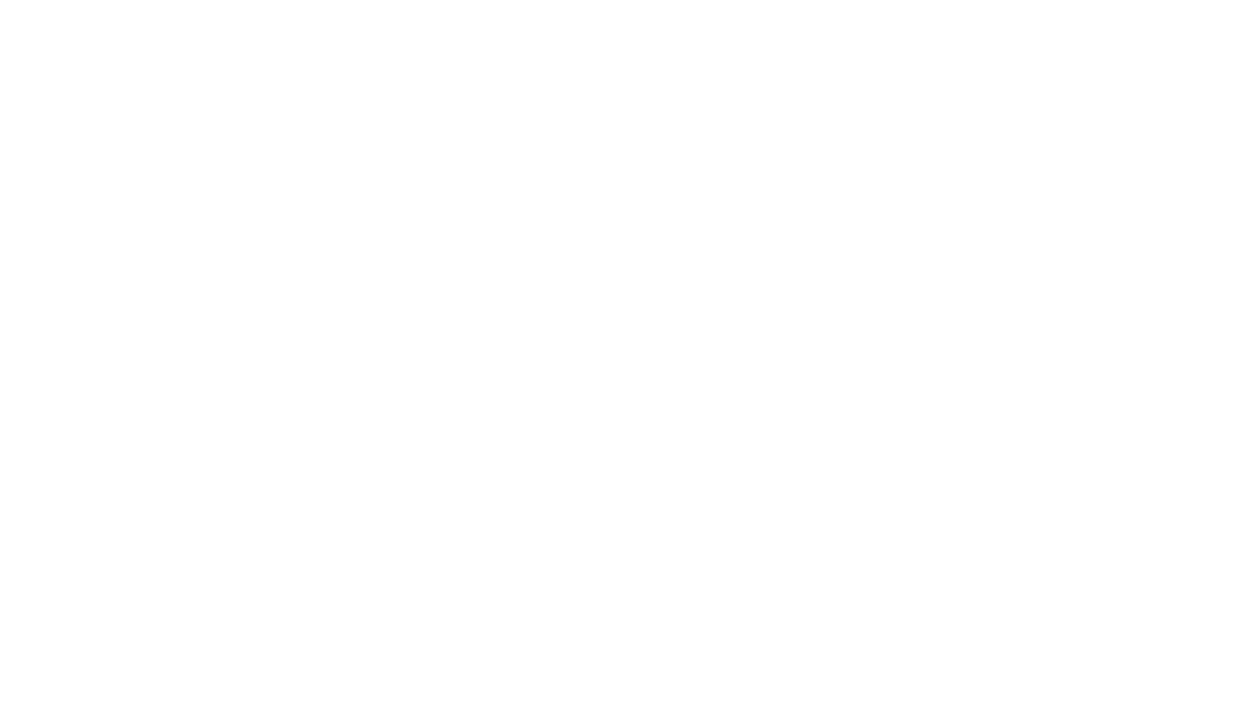
Figure 7. Same as Fig. 5, but from Hatoma Island (Group